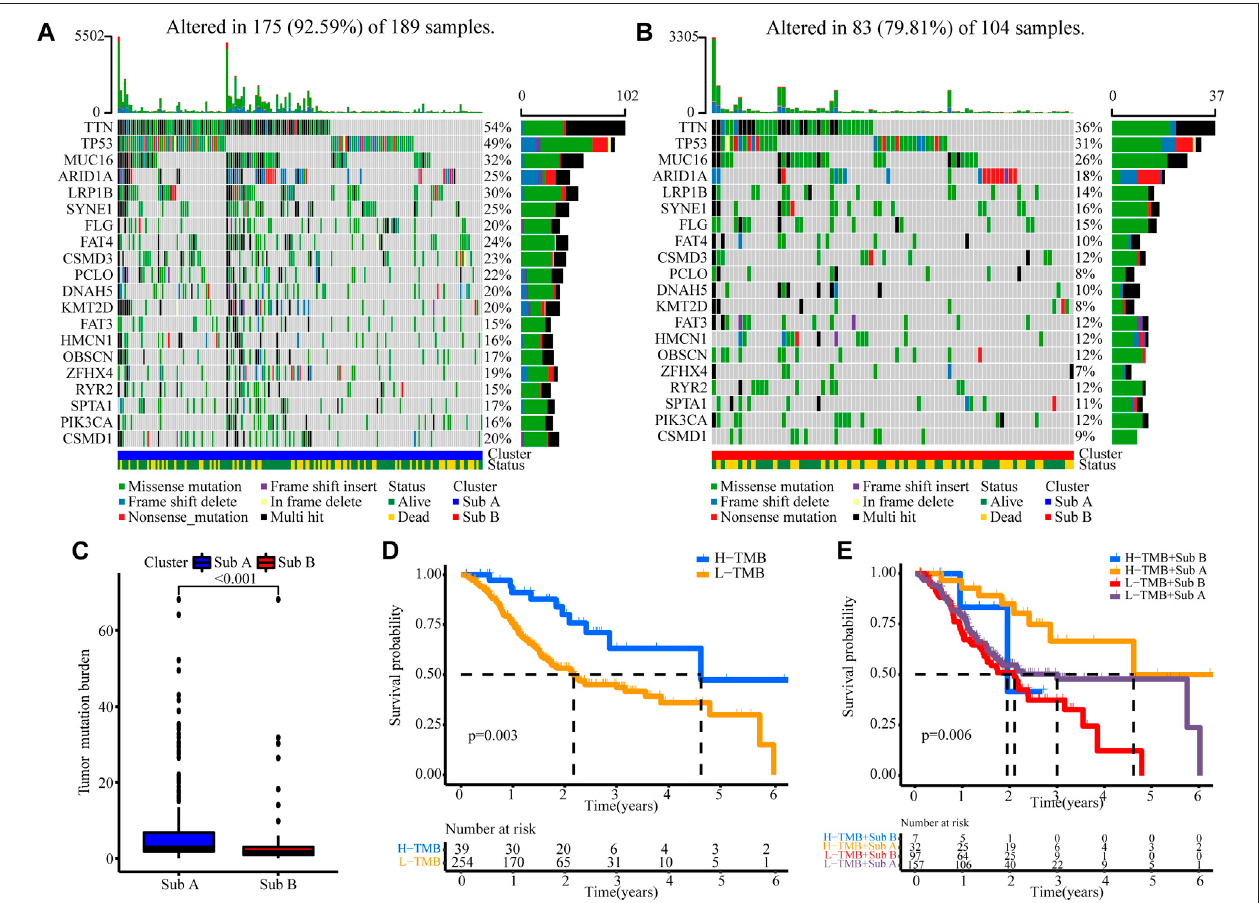
FIGURE 4 | The correlation between the TMB and clusters in TCGA cohort. (A) TMB analysis in the Sub A groups. (B) TMB analysis in the Sub B groups. (C) Difference analyses of TMB between Sub A and Sub B groups. (D) Kaplan-Meier curves for low and high TMB groups of the TCGA cohort. (E) Kaplan-Meier curves for patients in the TCGA cohorts strati fi ed by both TMB and clusters.